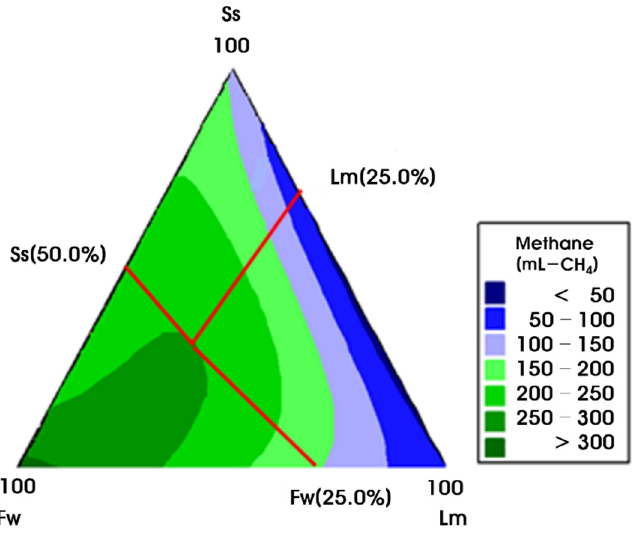
Figure 5. Determination of the optimal mixing ratio (Lm: Livestock manure; Ss: Sewage slduge; Fw: Food waste).